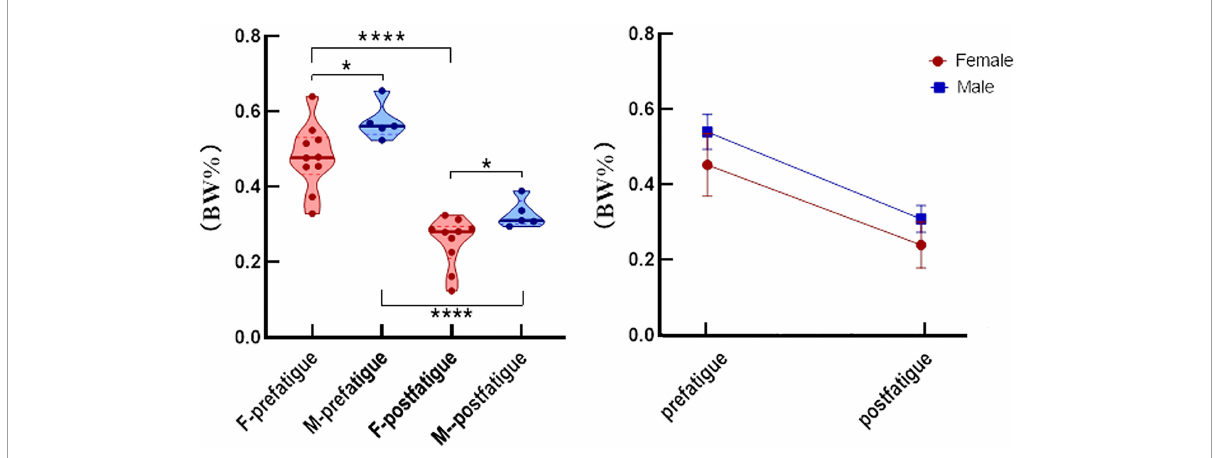
FIGURE3 After weight normalization, the average isometric hip strength (mean and standard error) was significantly different after fatigue in men (blue) and women (red). * P < 0.05, **** P < 0.0001.